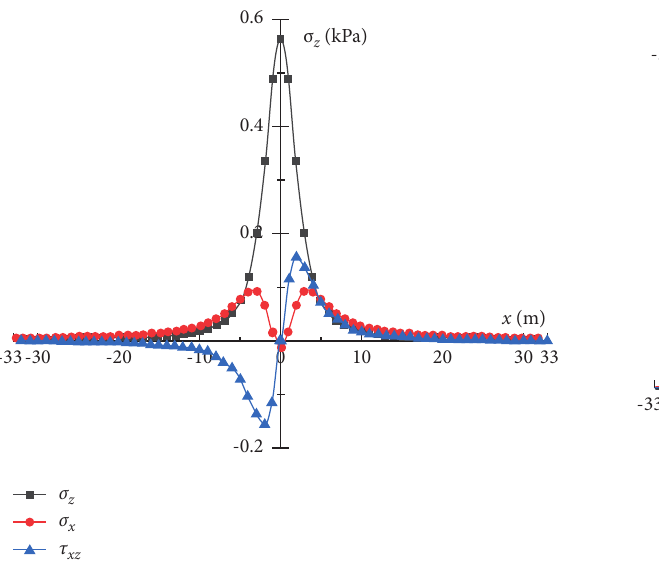
Figure 3: Changes of the soil stress state under a single wheel load.